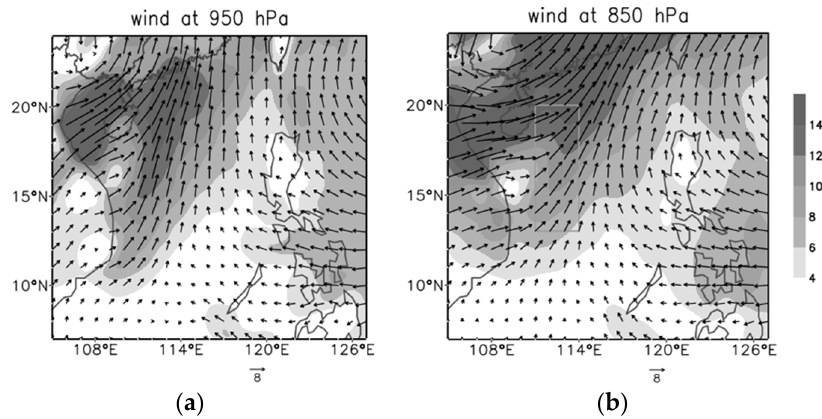
Figure 13. ERA interim daily fields of the horizontal wind speed (shaded, ms − 1 ) and wind barbs at ( a ) 950 hPa and ( b ) 850 hPa at 0000 UTC on 11 May 2014; the green rectangle denotes the area illustrated in Figure 14.